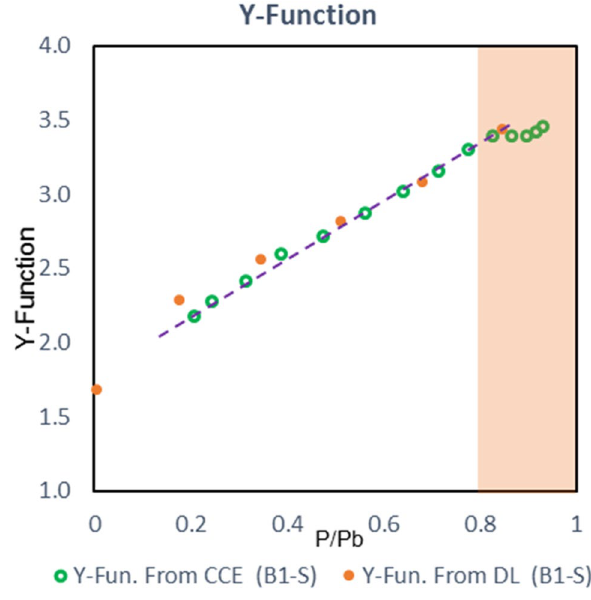
Fig. 23 Valid trend of Y-function of DL